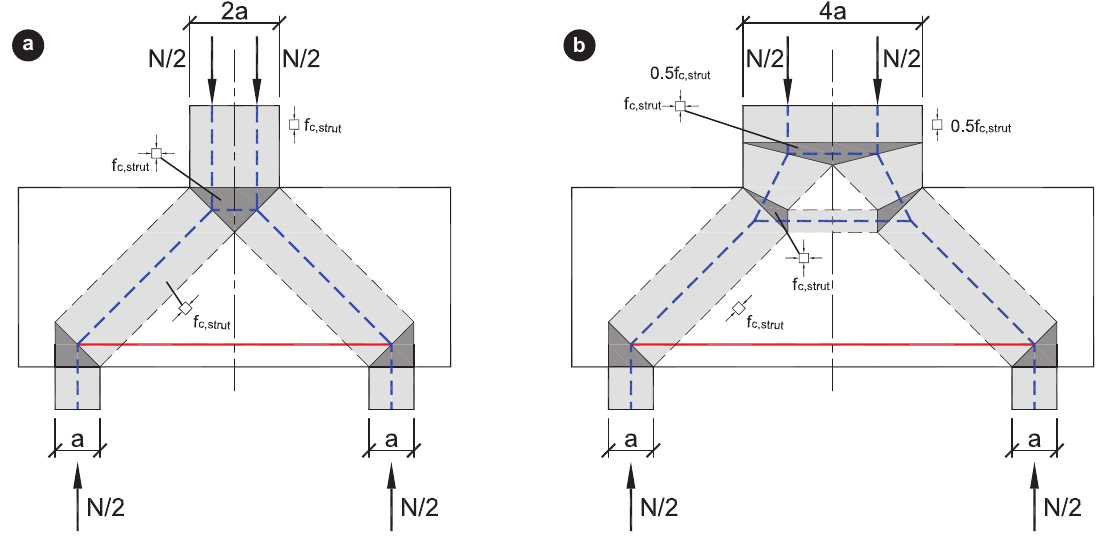
Strut-and-tie models for two-pile caps: a) The stress in the column is equal to the strength of concrete and b) The stress in the column is lower than the strength of